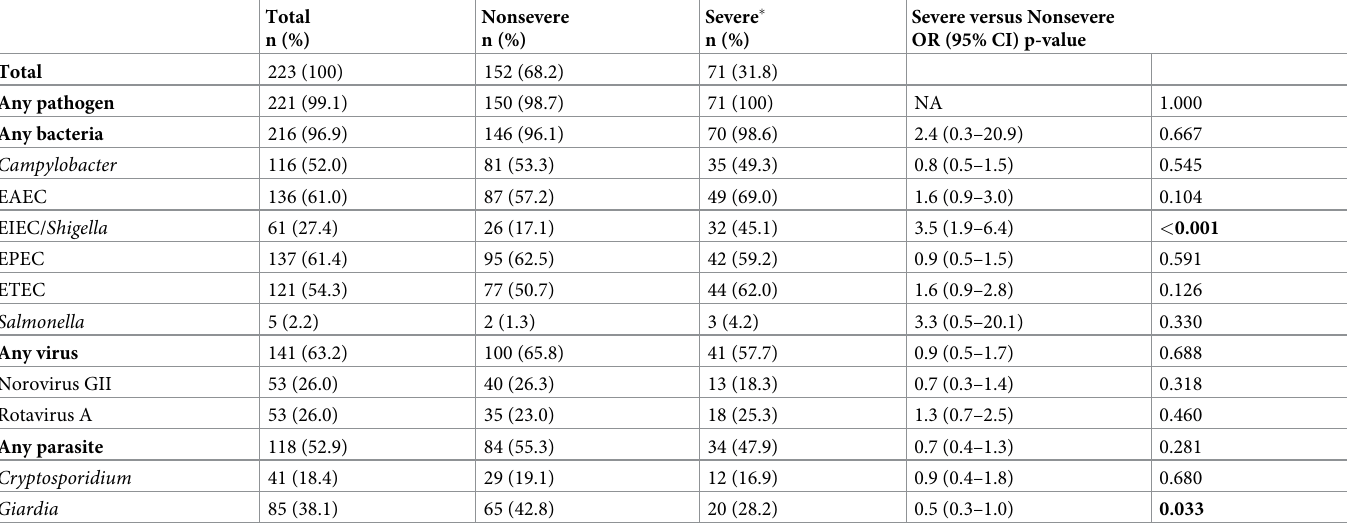
Table 4. Severity of diarrhoea. For severity analyses, the findings were selected that involved the six most common bacterial pathogens ( Campylobacter , EAEC, EIEC/ Shi- gella , EPEC, ETEC, Salmonella ), the two most common viruses (norovirus GII, rotavirus A) and the two most common parasites ( Cryptosporidium , G . duodenalis